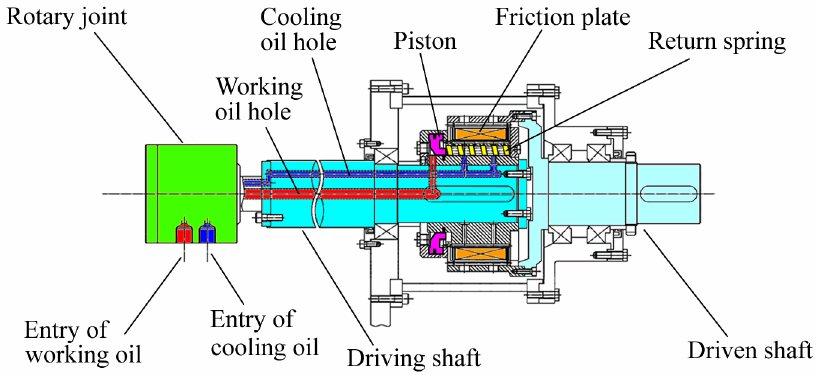
Figure 6. Structure of the wet clutch.